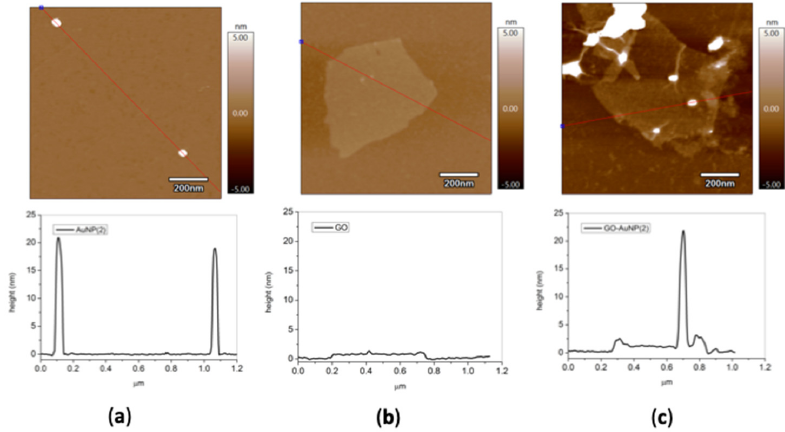
Figure 4. AC-mode atomic force microscopy (AFM) height images in air for (pellet 2) samples of: ( a ) AuNPs, ( b ) GO, ( c ) GO-Au-NP; z scale = 10 nm. The panels below each micrograph show the section analysis plots corresponding to the drawn line.